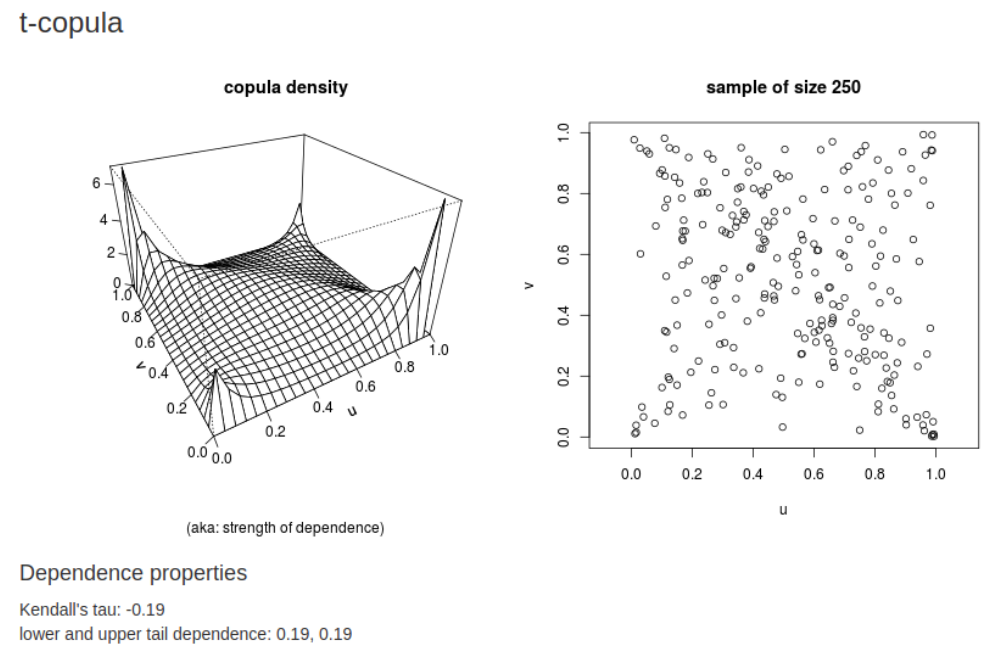
Figure 15. Student t − copula density with δ = 2 and with Kendall’s τ = −